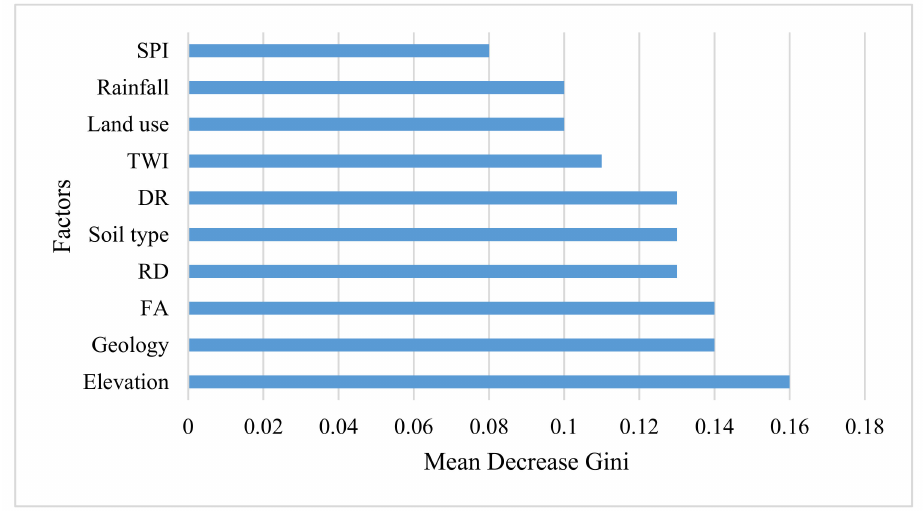
Figure 7. Weights of the coastal flood susceptibility determining factors found using